Question: How would you classify this visualization?
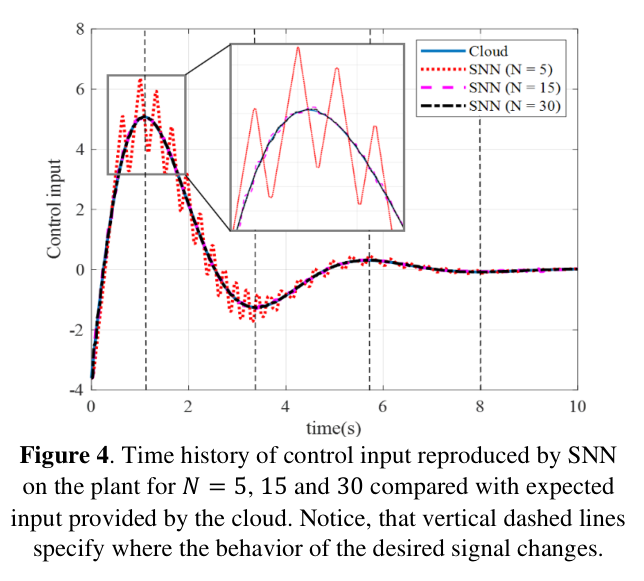
Answer: line